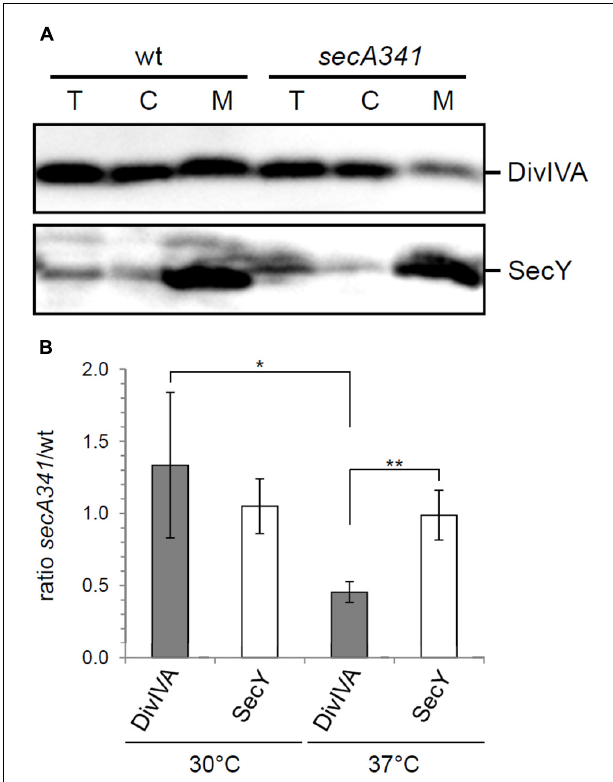
FIGURE 5 | SecA affects membrane targeting of DivIVA. (A) Distribution of DivIVA in membrane and cytoplasmic fractions of wild type cells (strain NIG1121), and in cells of the temperature sensitive secA341 mutant (strain NIG1152) during growth at 37 ◦ C. DivIVA concentrations were determined byWestern blotting (upper panel), and a parallelWestern blot using an antiserum directed against SecY was included as a control (lower panel, T – total extract, C – cytoplasm, M – membrane). Note that membrane samples have been concentrated 10-fold in the course of their isolation. (B) Densitometric quantification ofWestern blot signals from four independent experiments are shown in panel A .Values are given as ratios of DivIVA and SecY levels detected in the membrane fraction of secA341 cells relative to their levels in wild type cells at the indicated temperatures. Asterisks are used to indicate significance levels: P < 0.05 (*) or P < 0.005